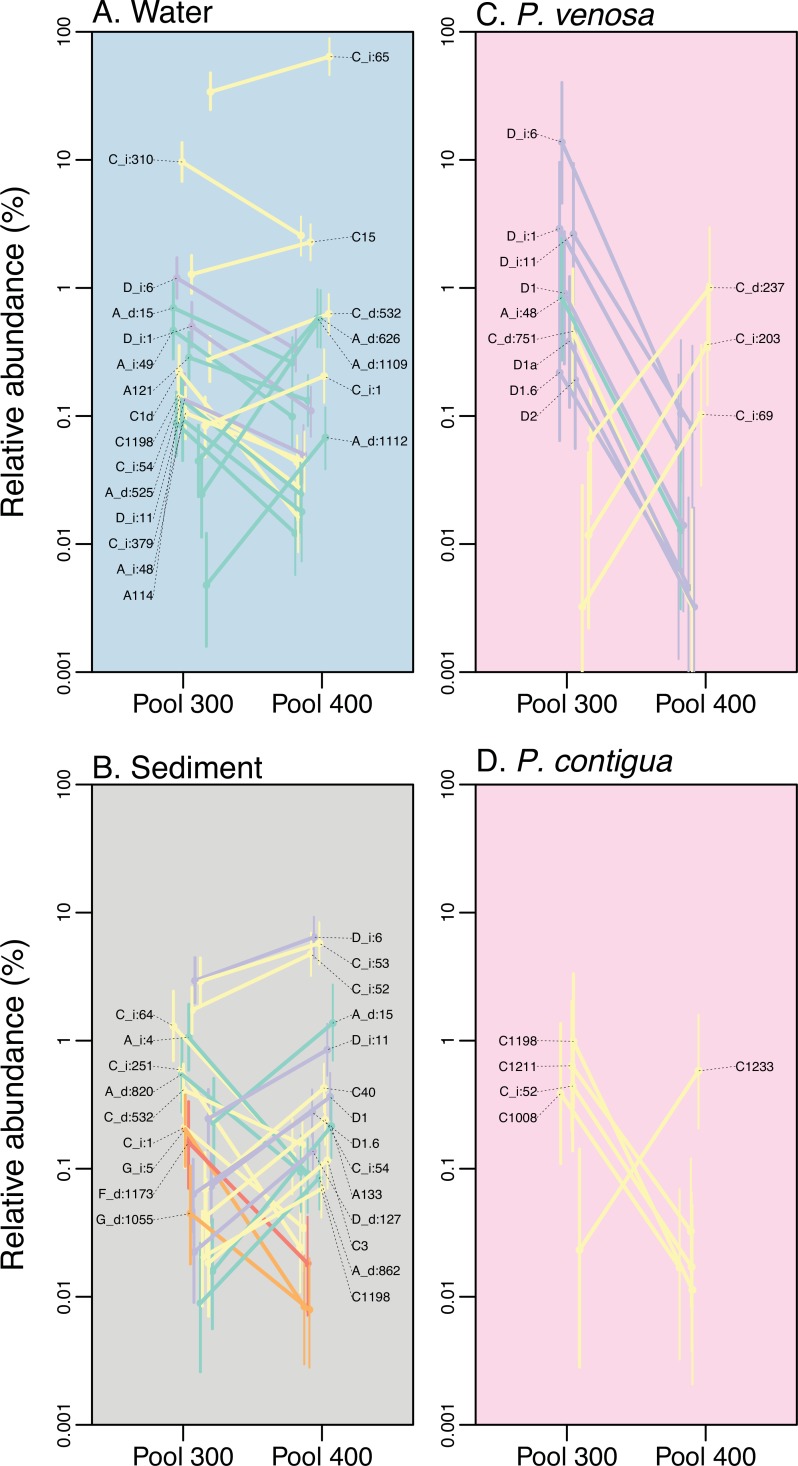
Differential abundance of Symbiodinium taxa between pools.Connected points colored by clade (A = green, C = yellow, D = purple, F = red, G = orange) indicate the relative abundance in each pool (computed relative to a “sum-OTU” with 95% credible limits [16]) of all differentially abundant taxa in water (A), sediment (B), Pavona venosa (C), and Psammocora contigua (D).